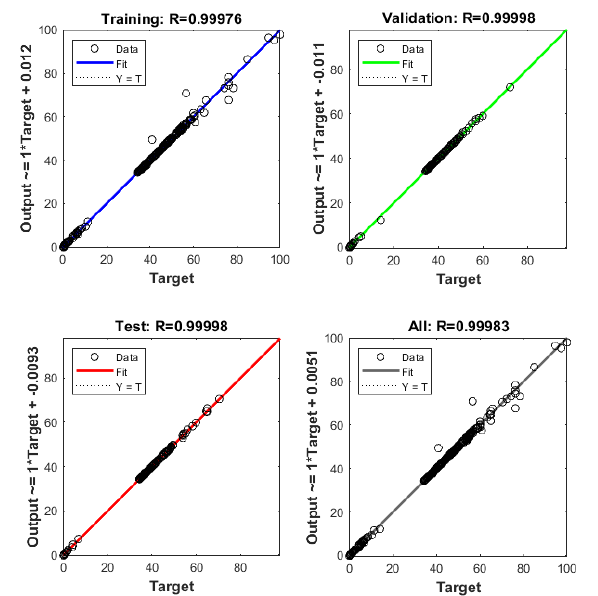
Figure 7. Training, Testing, Validation and overall R 2 = 0.9998 obtained for training data set. Figure 8 consists of a plot between Mean Squared Error (MSE) and Epochs. The best validation performance was obtained at epoch 528, with validation plot reaching its minimum MSE value of 0.12456.